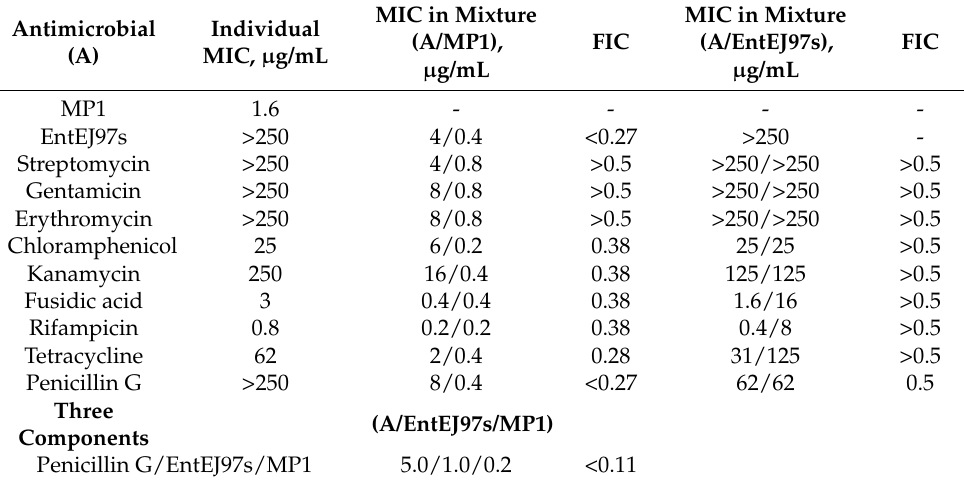
Table 1. Synergy assessment between MP1, EntEJ97s and a panel of antibiotics against LMGT 4219 after 24 h incubation (average of triplicate tests). Effects were considered synergistic if FIC was ≤ 0.5 for a two-component mixture and ≤ 0.75 for a three-component mixture. FIC 0.5–1 indicates additive effects [23].